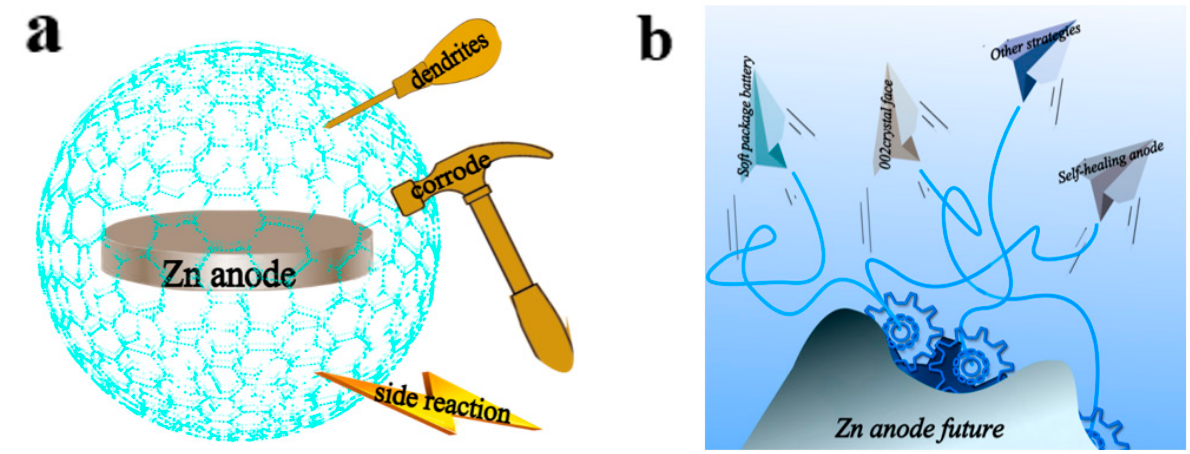
Figure 10. ( a ) Schematic of anode protection. ( b ) Diagram of the possible development directions of zinc anodes in the future.